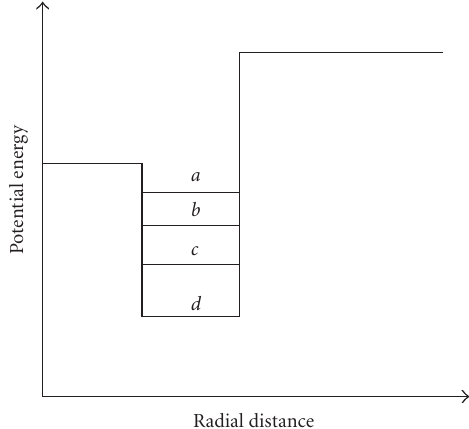
Figure 2: Potential energy variation along the radius for a core- shell microsphere. This figure shows the meaning of the varying refractive index of the shell. The higher the refractive index (n) of the shell, the deeper the quantum well. n ( a ) < n ( b ) < n ( c ) < n ( d ).